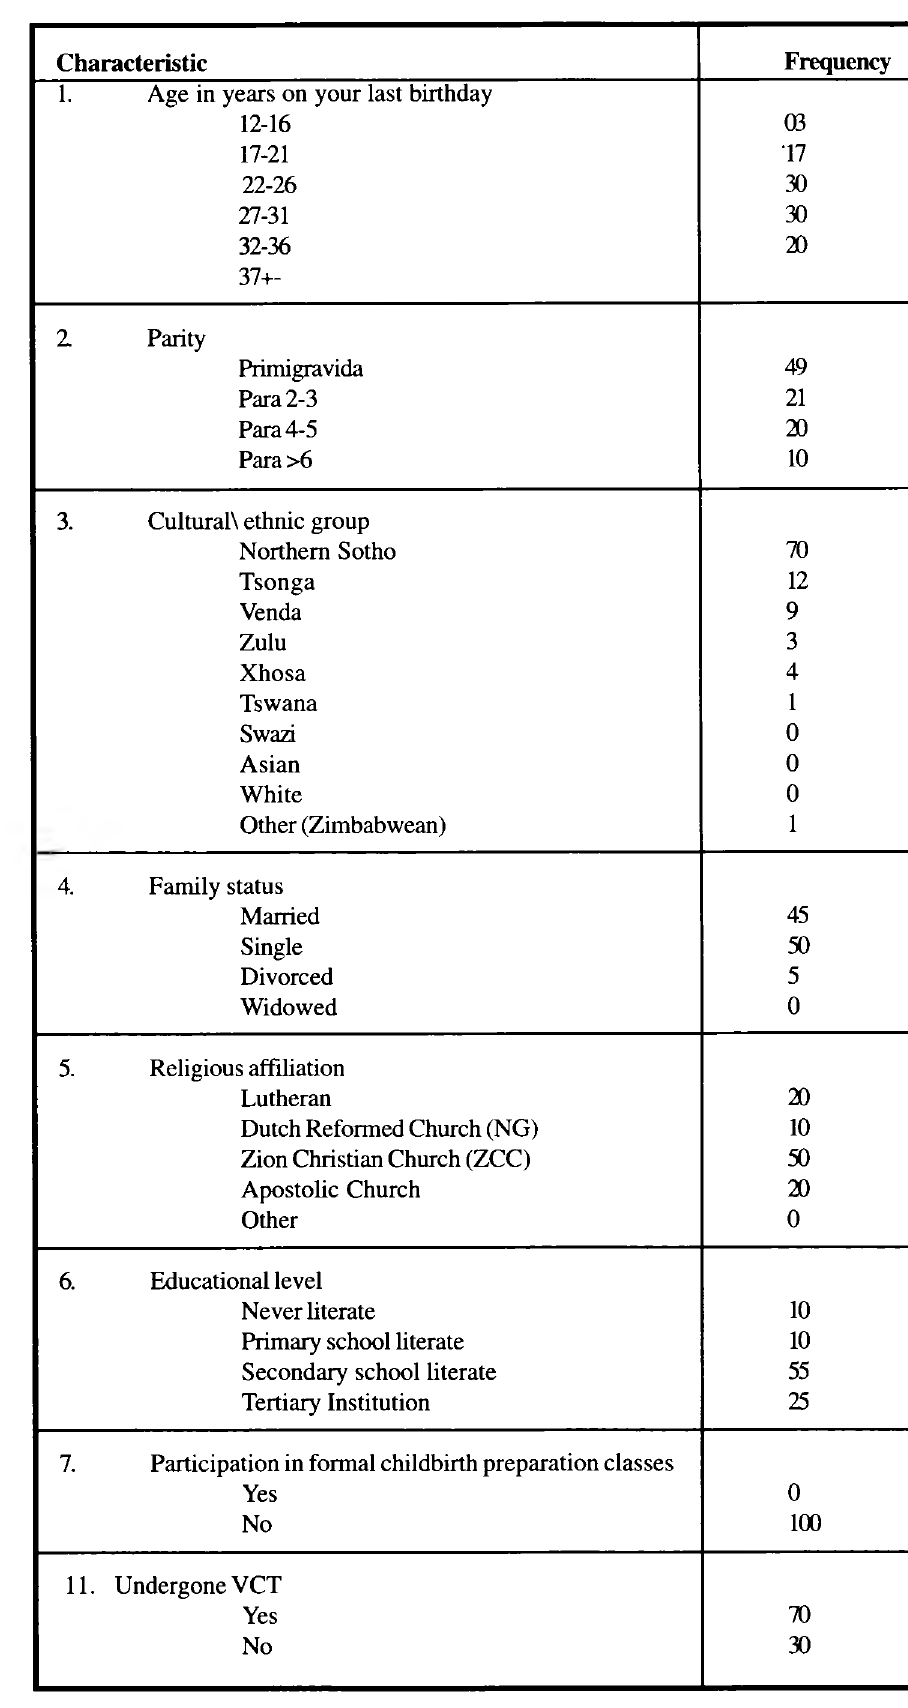
Table 1: Profile of pregnant women recruited for the study (n =100)